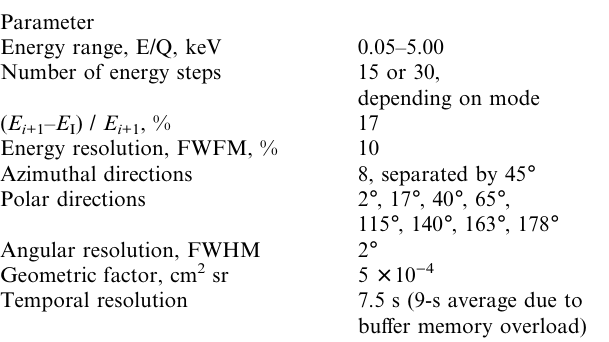
Table 1. Characteristics of EU-1/SCA-1 Parameter Energy range, E/Q,